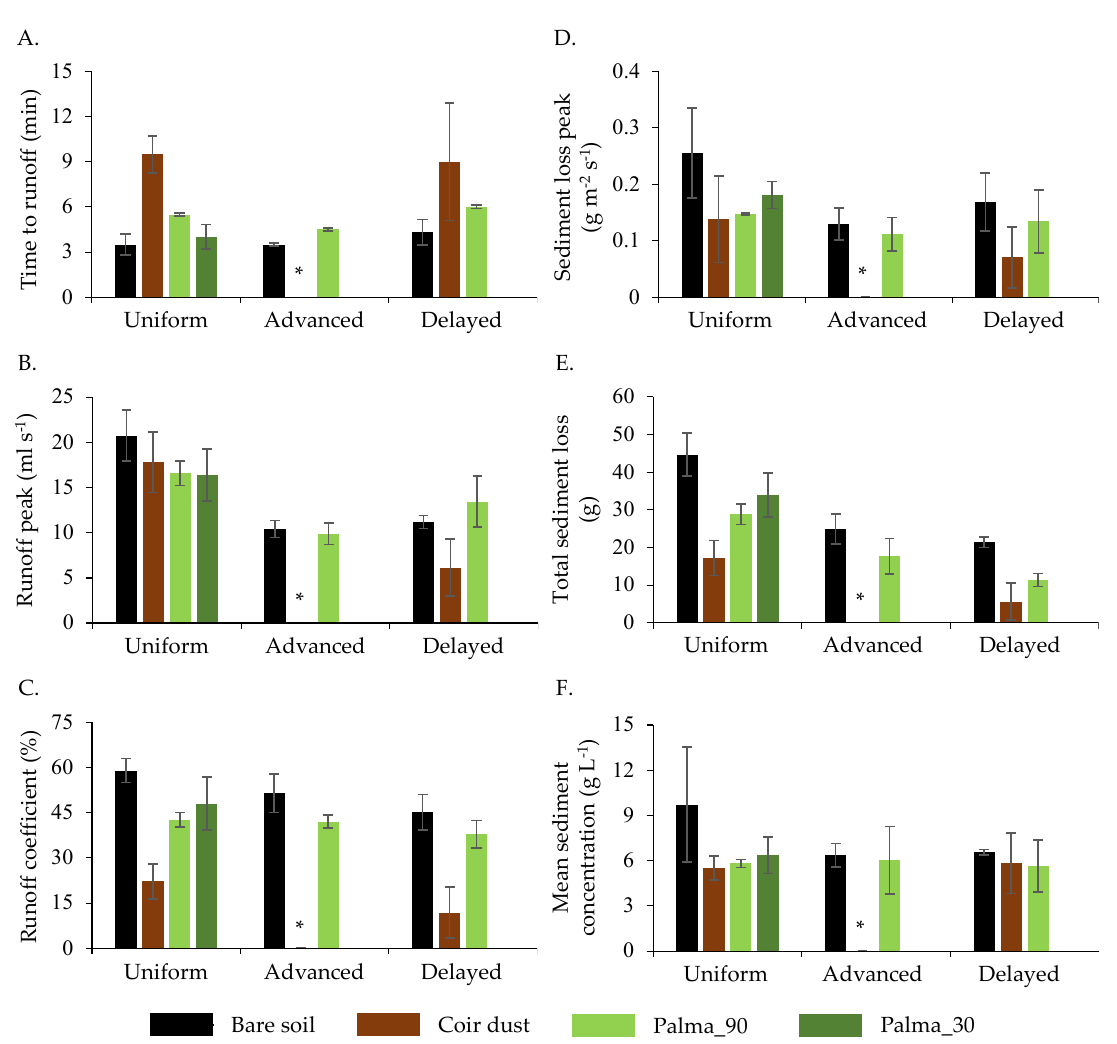
Figure 5. Bar graphs (mean and standard deviation of three repetitions) of parameters related to runoff and soil loss observed for all soil cover conditions and rainfall patterns simulated in the experiments: ( A ) Time to runoff, ( B ) runoff peak, ( C ) runoff coefficient, ( D ) soil loss peak, ( E ) total soil loss and ( F ) mean sediment concentration. For the coir dust and advanced rainfall pattern (*), no runoff and soil loss were observed at the downstream end of the flume and time to runoff was not measured.